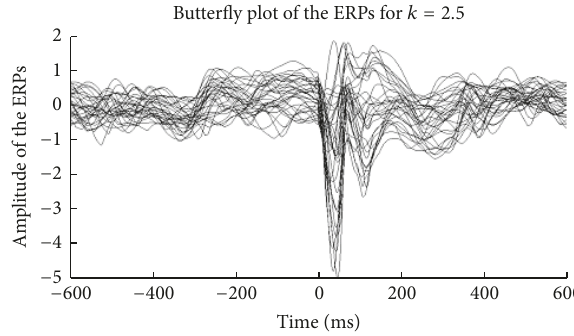
Figure 2: Butterfly plot from simulated ERPs with the model. In this case, the ERPs were produced for 𝑘 =